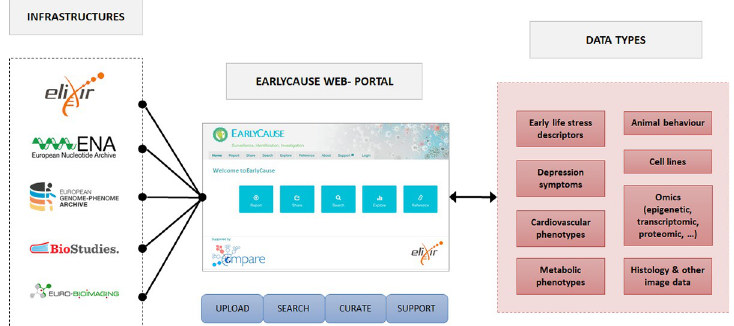
Fig 6. Overview of the EarlyCause centralised research platform, which will allow us to upload, search and manage human and experimental data for investigating ELS-induced multi-morbidity.